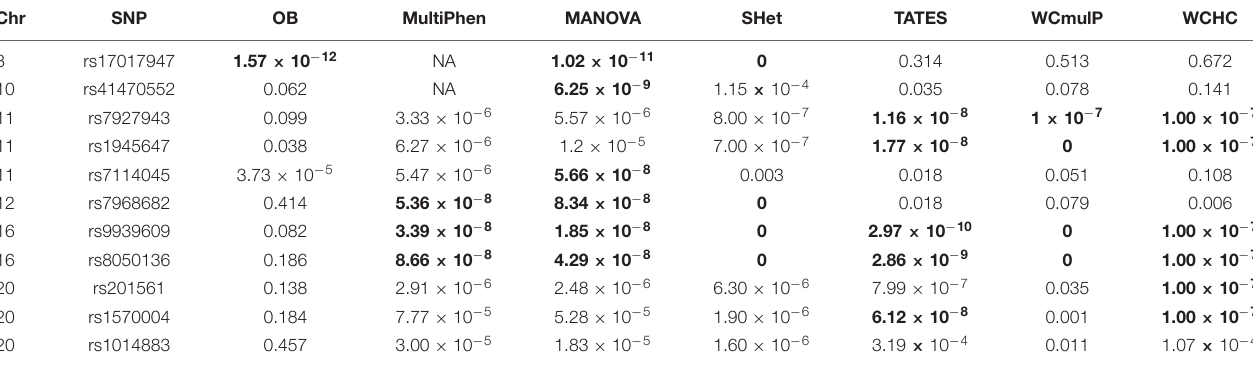
TABLE 4 | Significant SNPs and the corresponding p -values in the analysis of